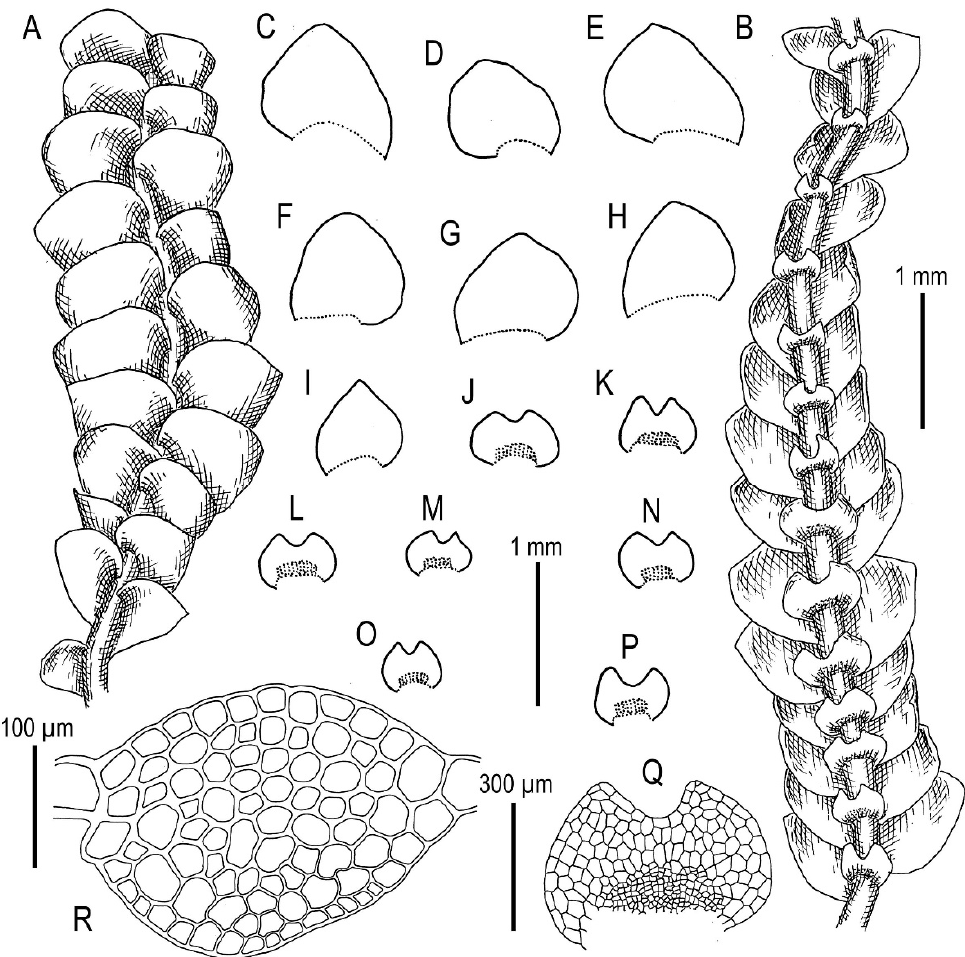
Figure 17. Calypogeia pseudosphagnicola Bakalin, Troizk. et Maltseva, sp. nov. : ( A ) Plant habit, fragment, dorsal view; ( B ) Plant habit, fragment, ventral view; ( C – I ) Leaves; ( J – Q ) Underleaves; ( R ) Stem cross-section. All from Kh-40-28-13 (VBGI).